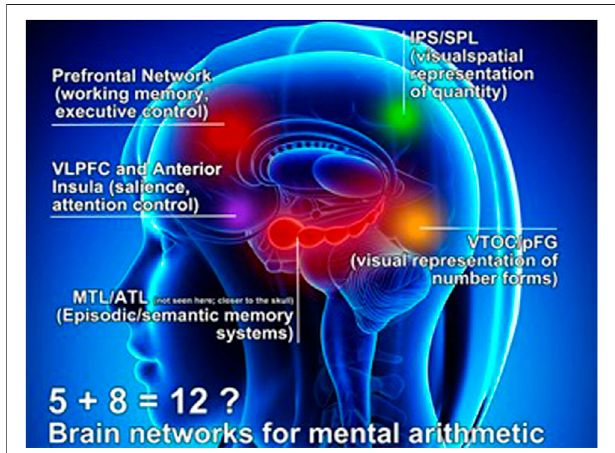
FIGURE 1 | Brain network underpinning mathematics knowledge, lang chen in Boaler